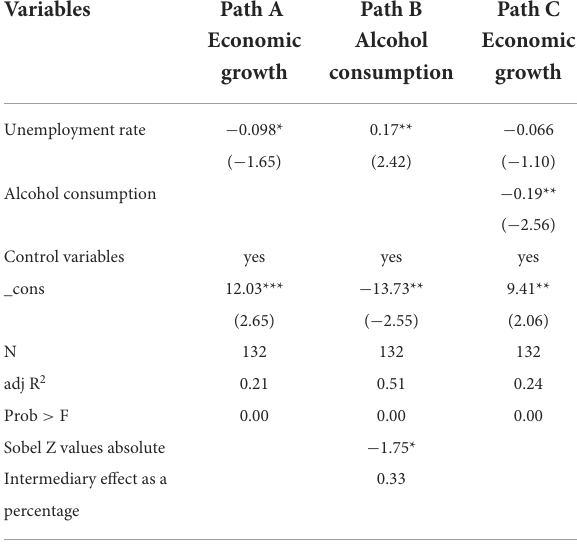
TABLE 5 Results of the Sobel mediating factor effect test.